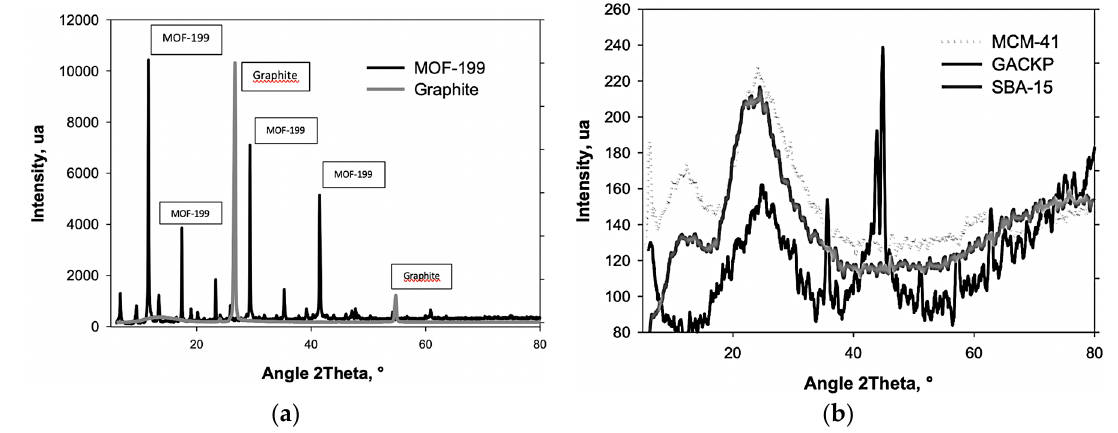
Figure 4. ( a ) XRD of MOF-199 and Graphite; ( b ) XRD of MCM-41, SBA-15 and GACKP.